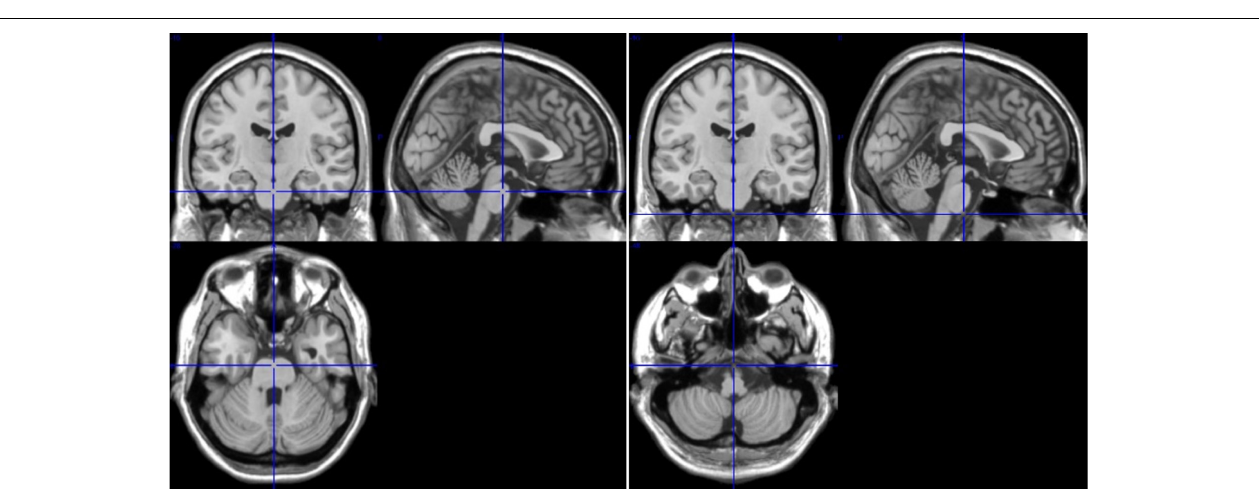
FIGURE 1 | RRI peak-triggered slow BOLD waves (mean ± SE) from 116 ROIs during rest. Respiratory artifacts of comparably large amplitude are prevalent in ROI 36 (right cingulum, supplied by anterior cerebral artery), ROIs 95, 96 (pons/brain stem, supplied by basilar artery) and ROIs 109–116 (vermis cerebelli, also supplied by basilar artery). The majority of ROIs exhibits artifact-free signals. Surprisingly, even a few ROIs in pons/brain stem (e.g., ROI 91 and 93) are of satisfying signal quality.